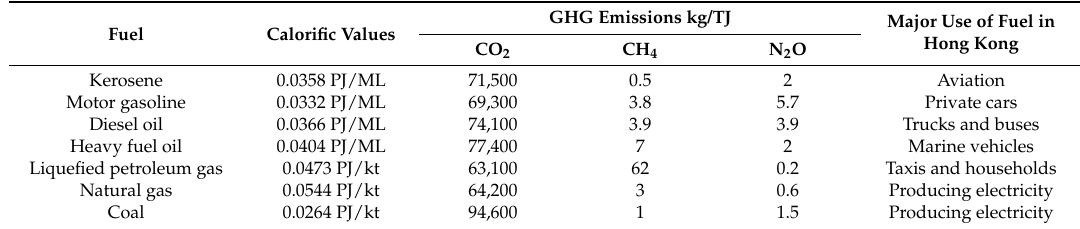
Table 1. Calorific values and emission factors of different fossil fuels